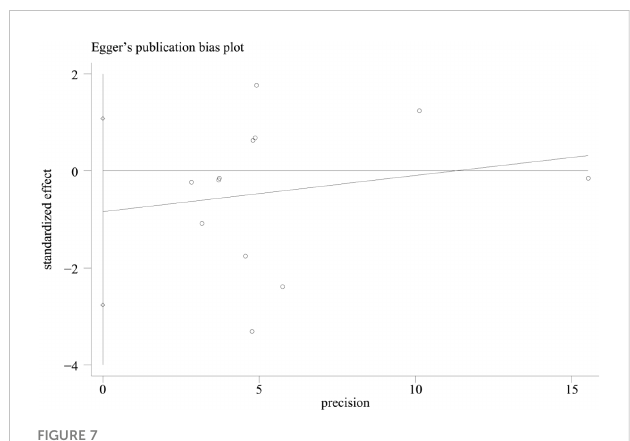
FIGURE 7 Egger ’ s publication bias plot of hazard ratios for overall survival